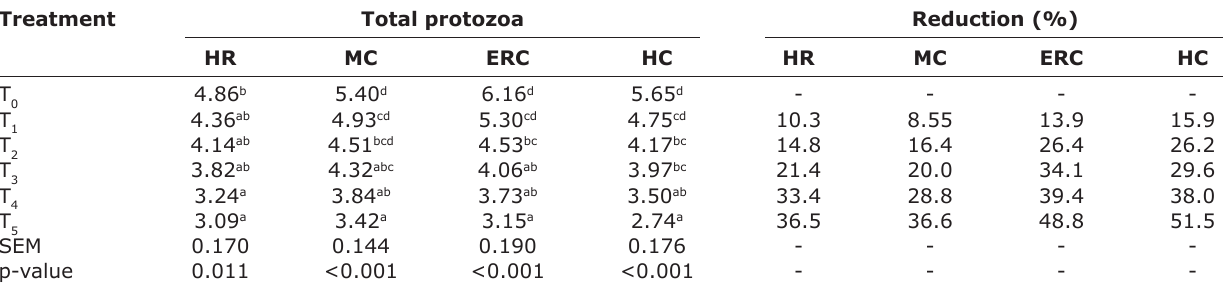
=Silkworm pupae oil supplementation at 2% of basal 3 diet, T =Silkworm pupae oil supplementation at 4% of 4 basal diet, and T =Silkworm pupae oil supplementation 5 at 5% of basal diet. SEM=Standard error of mean, Mean values bearing different superscripts in a column differ significantly Table-7: Effect of silkworm pupae oil supplementation at graded levels with different dietary regimes on total protozoal population (×10 6 /ml). Treatment Total protozoa